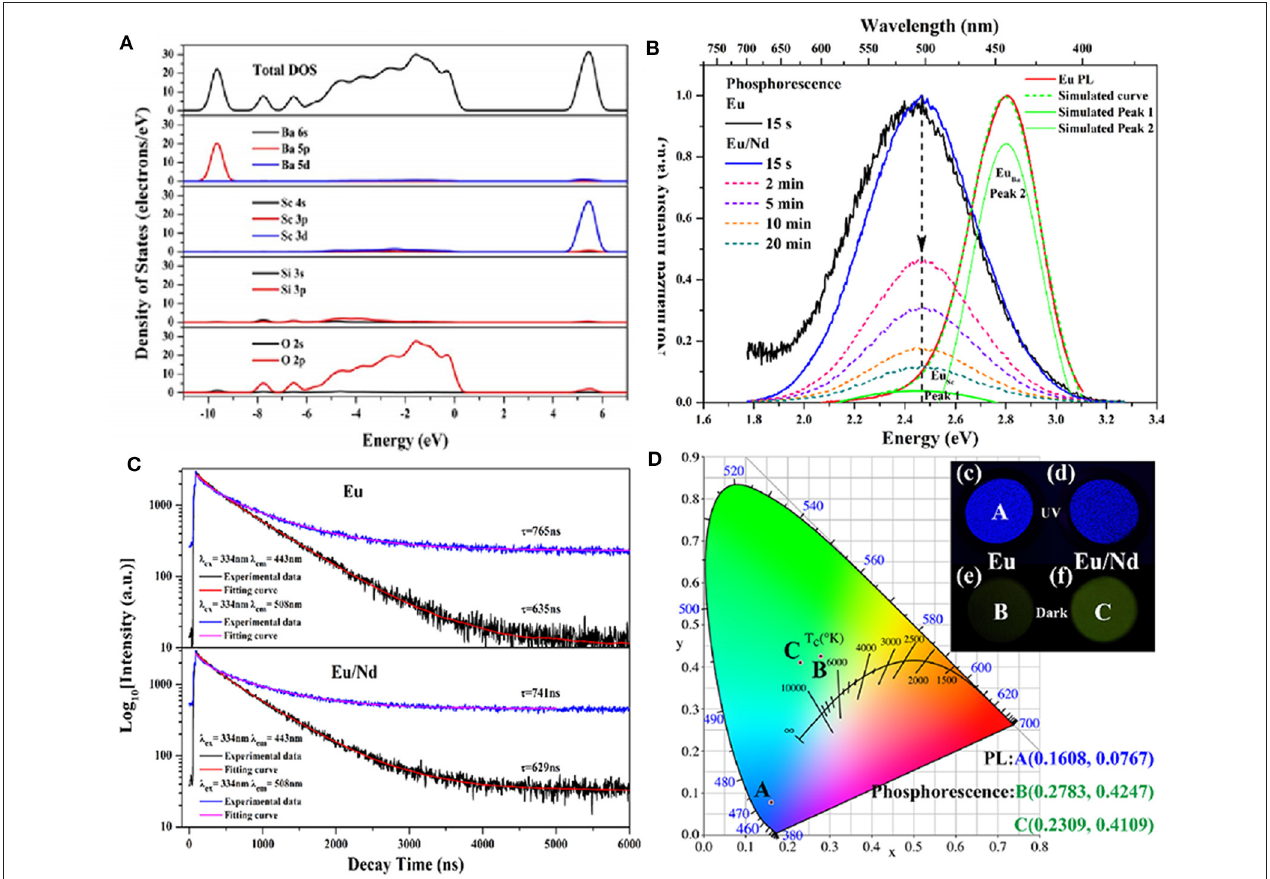
FIGURE 8 | (A) Total and partial density of states of BaSc 2 Si 3 O 10 . (B) The normalized PL spectrum and LPL spectra of BaSc 2 Si 3 O 10 : 0.01Eu 2 + and BaSc 2 Si 3 O 10 : 0.01Eu 2 + , 0.01Nd 3 + . (C) The luminescence decay curves of BaSc 2 Si 3 O 10 : 0.01Eu 2 + and BaSc 2 Si 3 O 10 : 0.01Eu 2 + , 0.01Nd 3 + excited at 334nm and monitored at 443 and 508nm, respectively. (D) CIE chromaticity coordinates and photographs for the PL and LPL of BaSc 2 Si 3 O 10 : 0.01Eu 2 + and BaSc 2 Si 3 O 10 : 0.01Eu 2 + , 0.01Nd 3 + . Reproduced with permission from Li G. et al. (2017), copyright 2017,